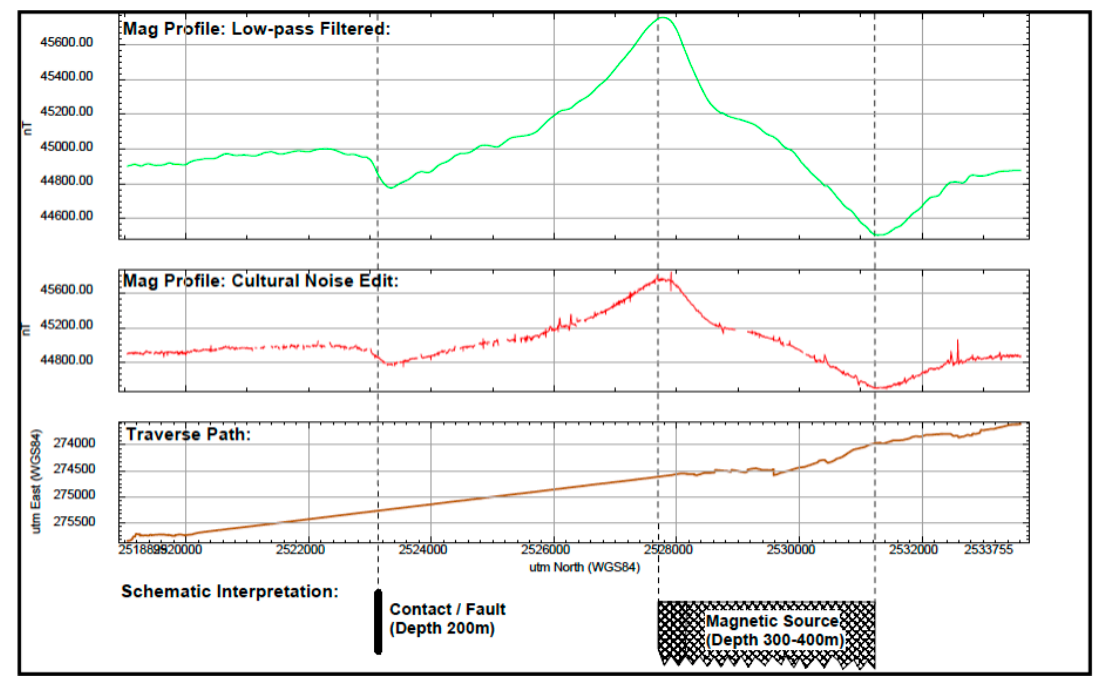
Minerals 2020 , 10 , x FOR PEER REVIEW Figure 5. The Magnetic profile along traverse path, magnetic data and low pass filter. Figure 5. The Magnetic profile along traverse path, Magnetic data and low pass filter.